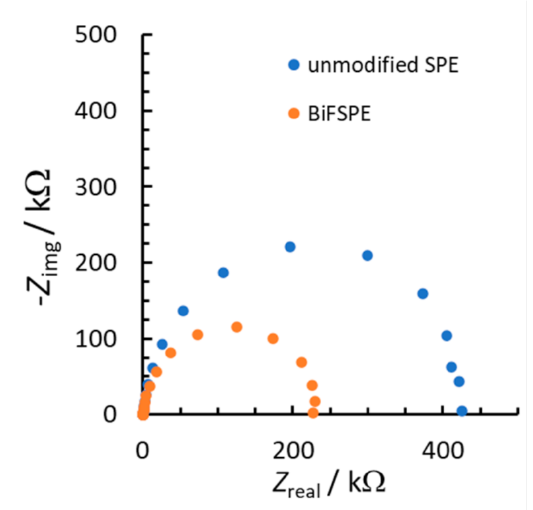
Figure 4. EIS Nyquist spectra measured for unmodified SPE and BiFSPE in 0.1 M acetate buffer containing 140.0 µ g/L